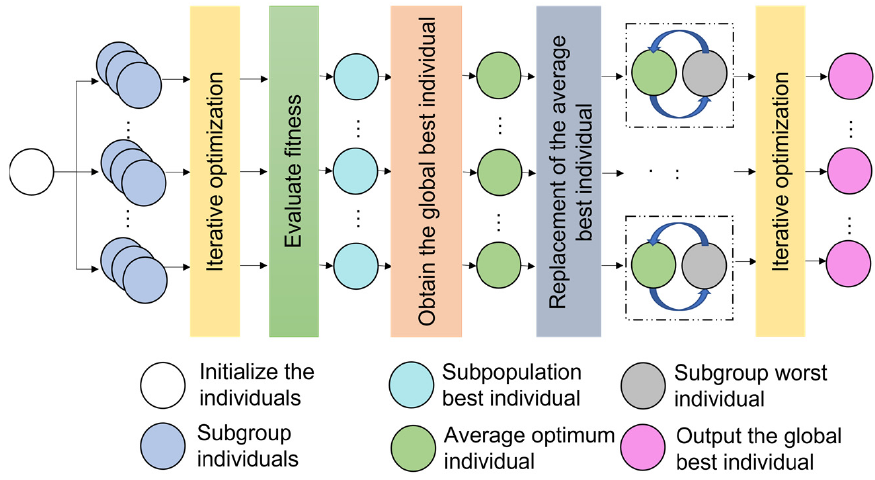
Figure 3. Execution flow of Strategy 2.